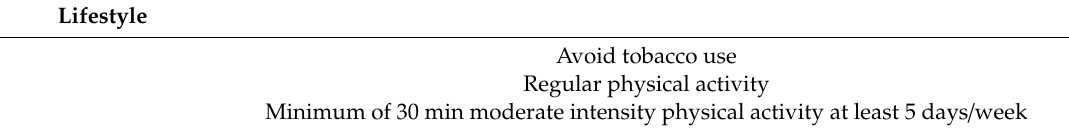
Table 1. Diet and lifestyle recommendations for atherosclerosis prevention in the primary care